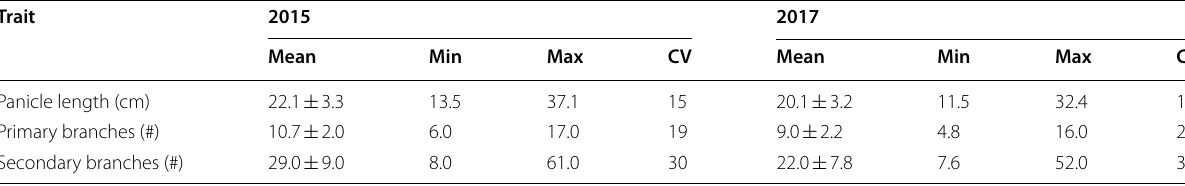
Branch numbers per panicle; mean CV coefficient of variation (%)